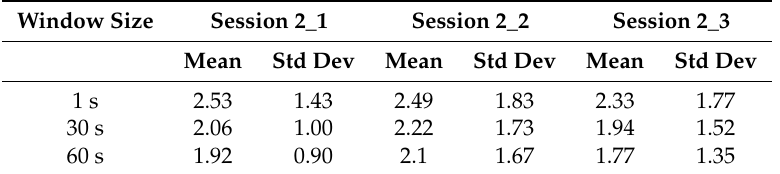
Table 4. Localization error for two-participant sessions, using motion-sensor and BLE-Estimote data with only one participant holding a phone. All the measurements are in